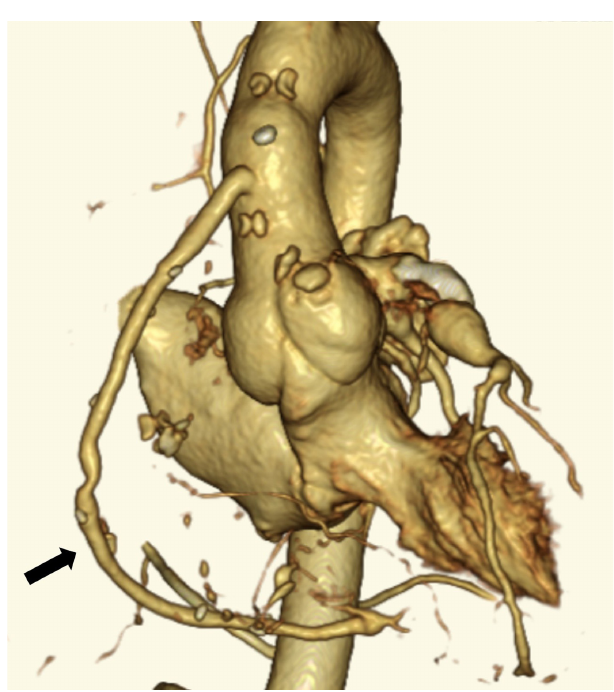
Fig. 3 - Postoperative cardiac computed tomography scan showing that the saphenous vein graft is patent (arrow) and the right super- giant coronary artery aneurysm has